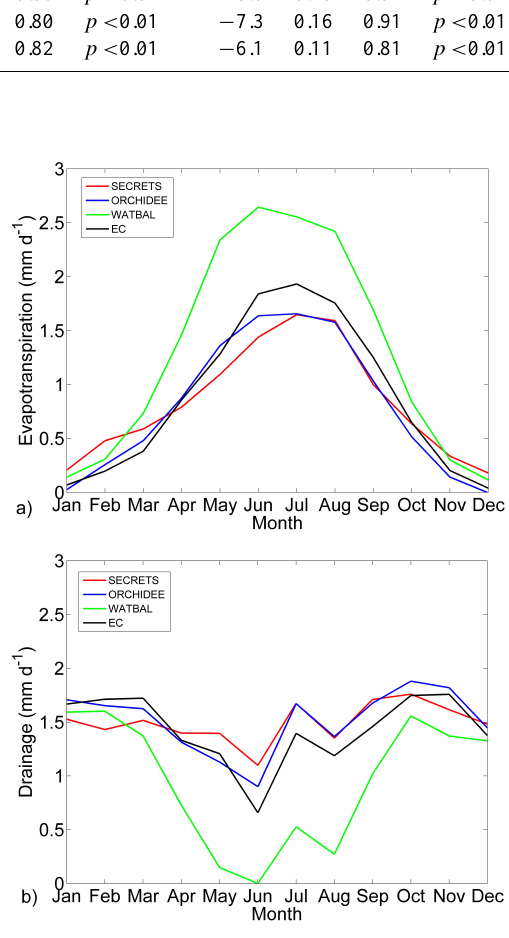
Fig. 6. The seven year mean seasonal patterns of evapotranspira- tion (ET) (a) and drainage (b) expressed as mm month-1 for OR- CHIDEE (blue), SECRETS (red),WATBAL (green) and EC (black). 1998, 1999 and 2003 were excluded because there were no EC